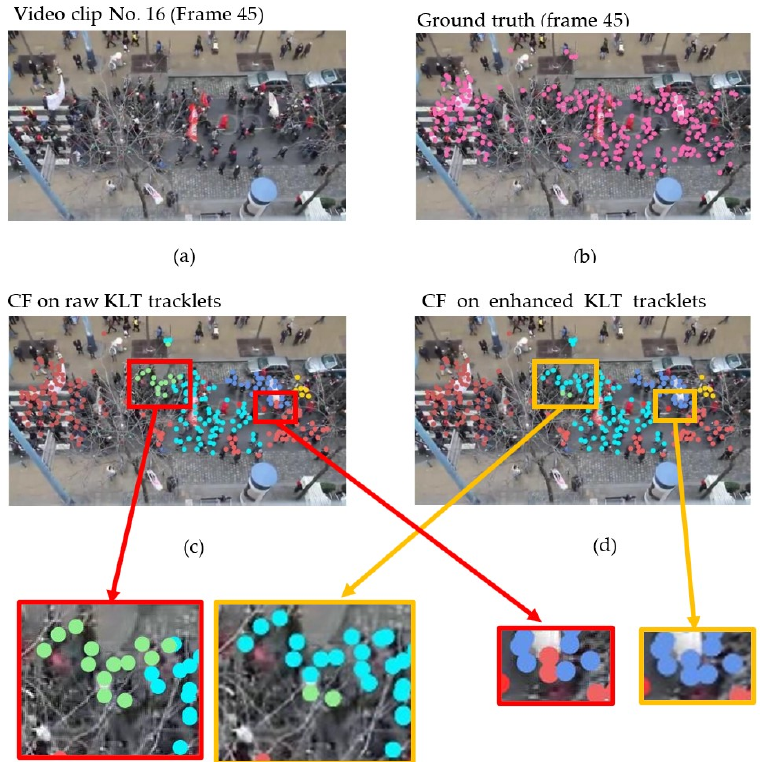
Figure 8. An example of the effect of applying the HTA algorithm on KLT tracklets of video clip No. 16. Colored KLT points represent coherent moving clusters. ( a ) Scene from video clip No. 16—frame 45. ( b ) Ground truth of video clip 16—frame 45. ( c ) The visual results of CF crowd motion clustering using the raw KLT tracklet features. ( d ) The visual results of CF crowd motion clustering using the enhanced KLT tracklet features by HTA